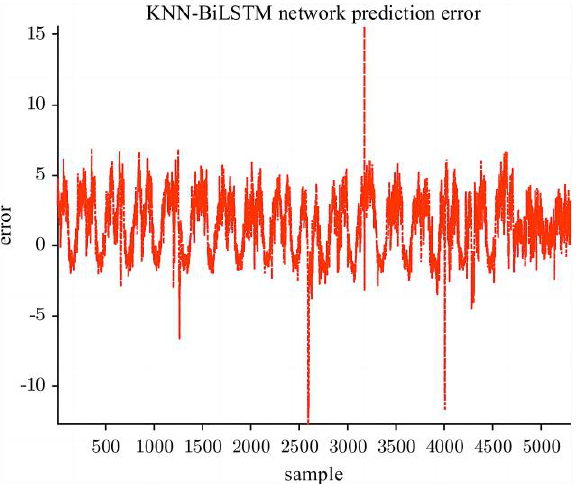
Figure 9. New data prediction error.